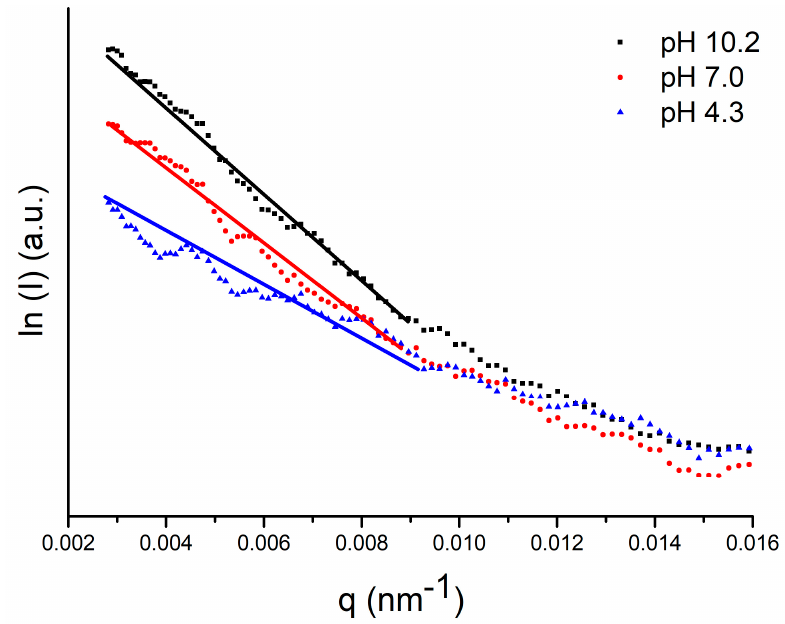
Figure 2. SAXS curves of G4PAMAM dendrimer 2.5% in 1 × 10 − 2 NaCl 10 at different pH. Table 1. Average values of the radius of gyration R g acquired by [a] SAXS and [b] MD for G4PAMAM dendrimer. Values of the hydrodynamic radius R H were determined from [c] DLS measurements. ( I = 1 × 10 − 2 NaCl).